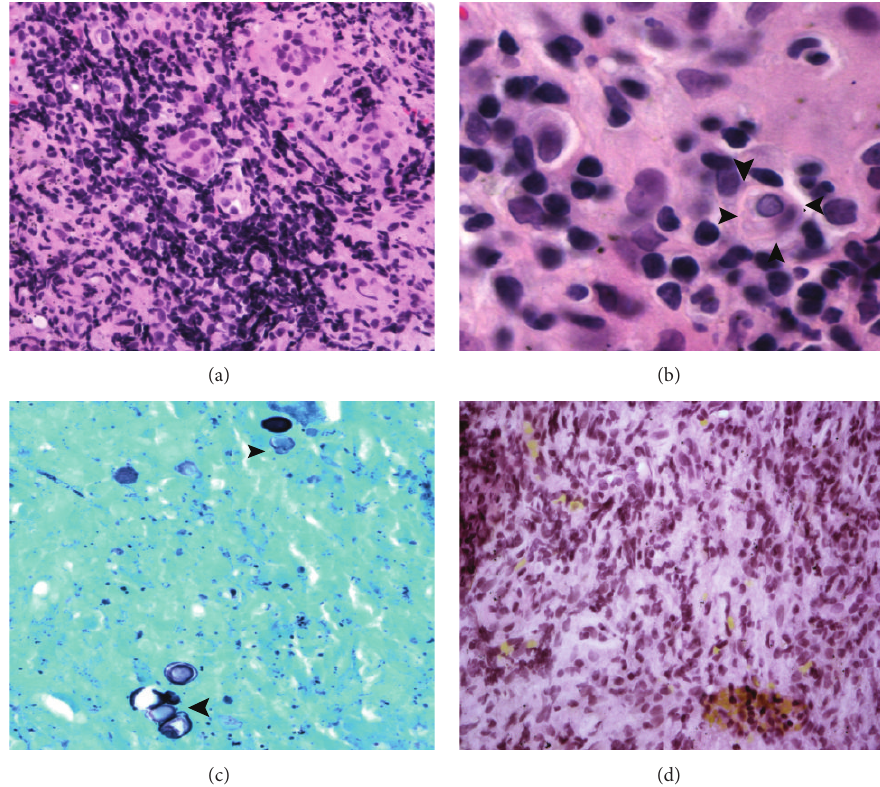
Figure 5: Representative photomicrographs from the transbronchial lung biopsy. (a) Lymphocytic infiltration and multiple giant cells (H & E, × 200). (b) Intracellular fungal organism within a giant cell (arrowheads) (H & E stain × 600). (c) Yeast-like cells of Blastomyces dermatitidis . Note the characteristic broad based budding (arrowhead) (GMS stain, × 400). (d) A representative section with negative mucicarmine stain ( ×